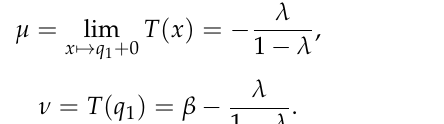
Figure 2. A sample form of the map T